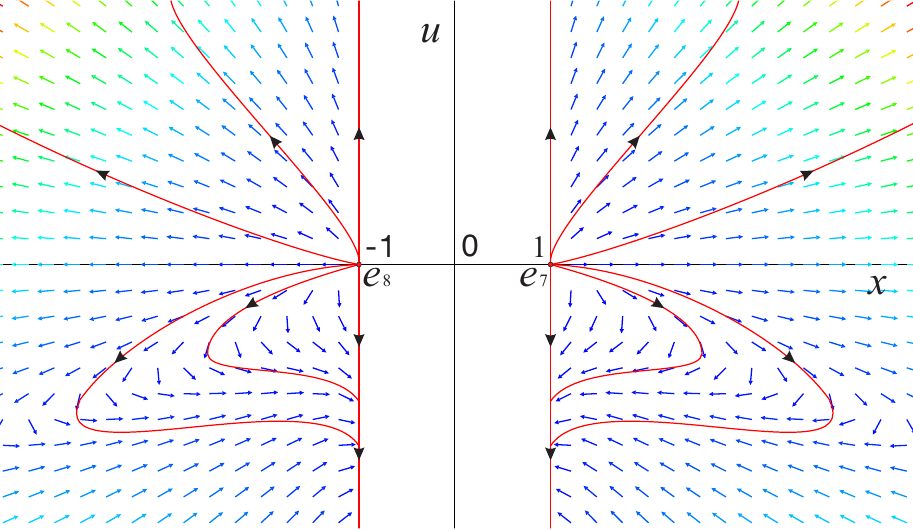
Figure 6. The phase portrait on the invariant surface f + ( x , z , u ) = 0 restricted to the region u ≥ z . Similarly, the local phase portrait of system (17) is shown in Figure